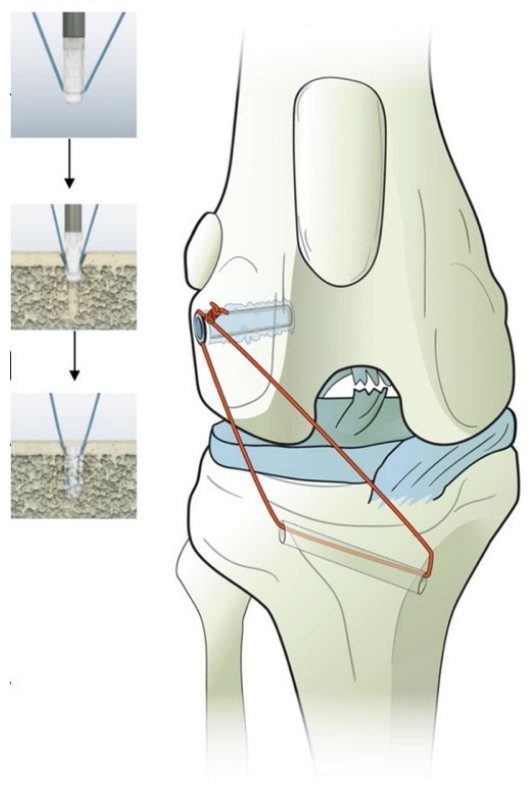
Figure 2. Illustration of the polylactide absorbable bone anchor (Weldix; VetWelding AG, Stansstad, Switzerland), its position in the femoral condyle and the bone tunnel through the tibia. The smaller images show the process of implantation from top to bottom.